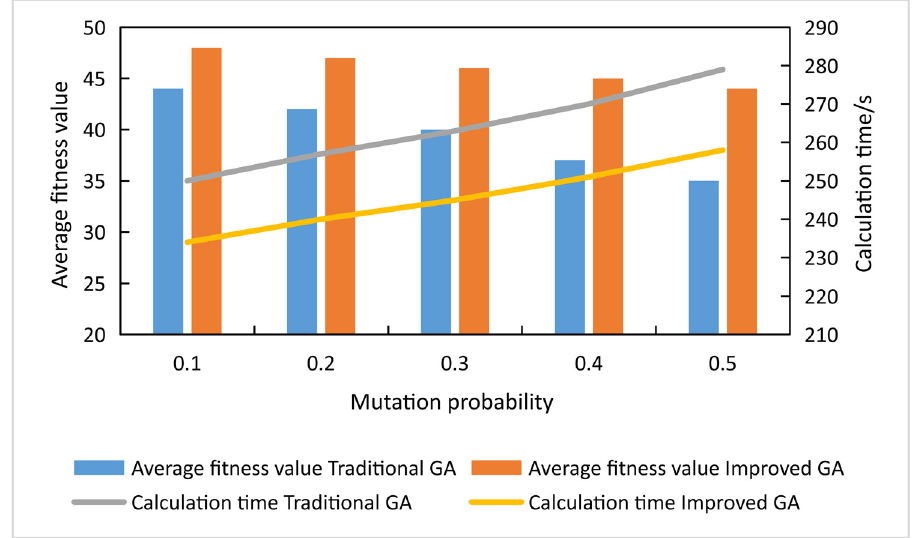
Figure 6: Performance of two genetic algorithms under di ff erent variation probabilities when the crossover probability is